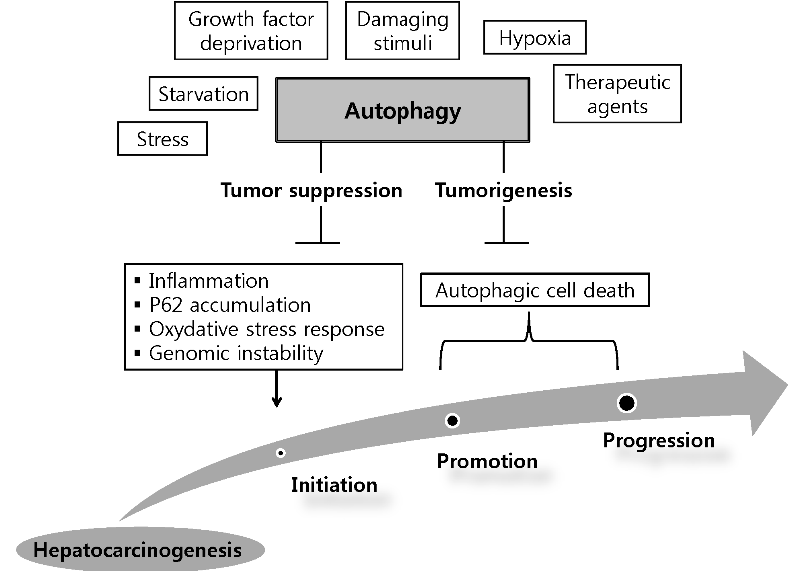
Figure 1. Dual role of autophagy in the initiation and development of hepatocellular carcinoma. Hepatic autophagy is activated by various factors. By limiting inflammation, P62 accumulation, oxidative stress response and consequently inhibiting genomic instability, autophagy can serve as a tumor suppressor in the initiation stage of hepatoneogenesis. On the other hand, autophagy can facilitates tumorigenesis via autophagic cell death in other stages of hepatoneogenesis.